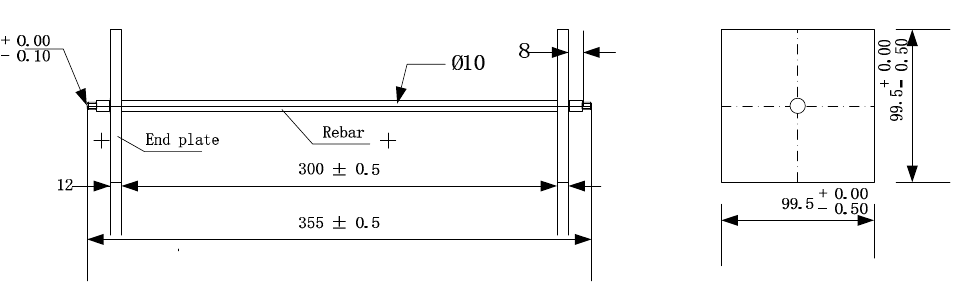
Figure 1. The measurement of mass loss of steel bars.